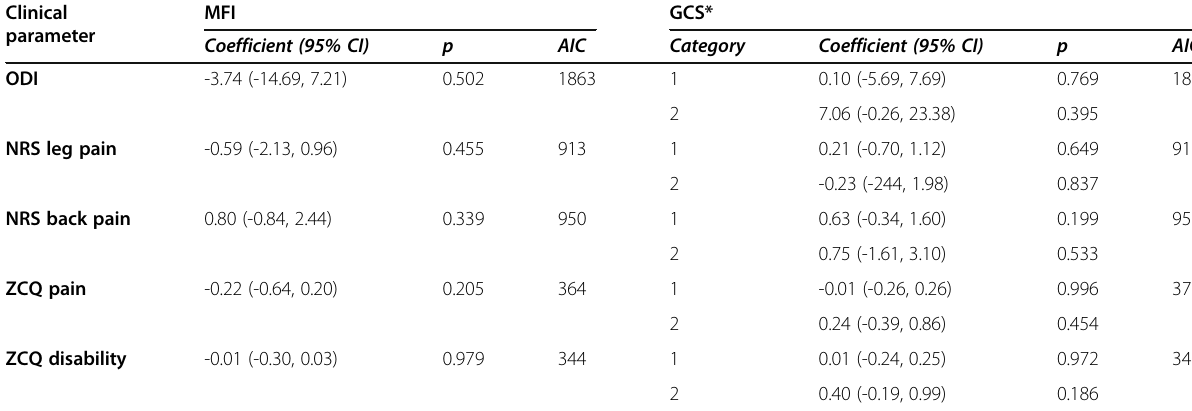
Table 6 Multivariate regression analyses Clinical